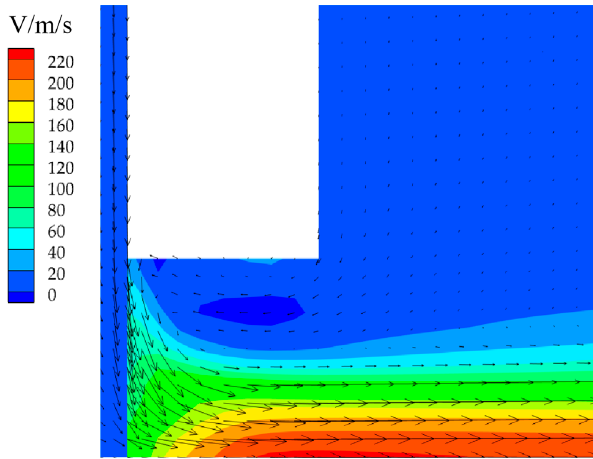
Figure 8. Fluid speed distribution.